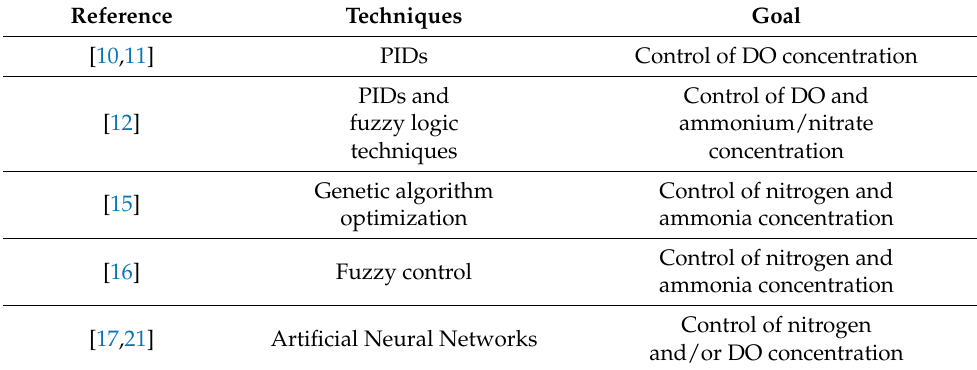
Table 1. Control approaches in